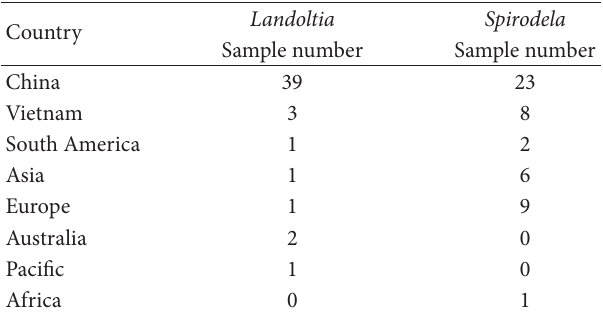
Table 1: Number of ecotypes per country and geographical area for samples